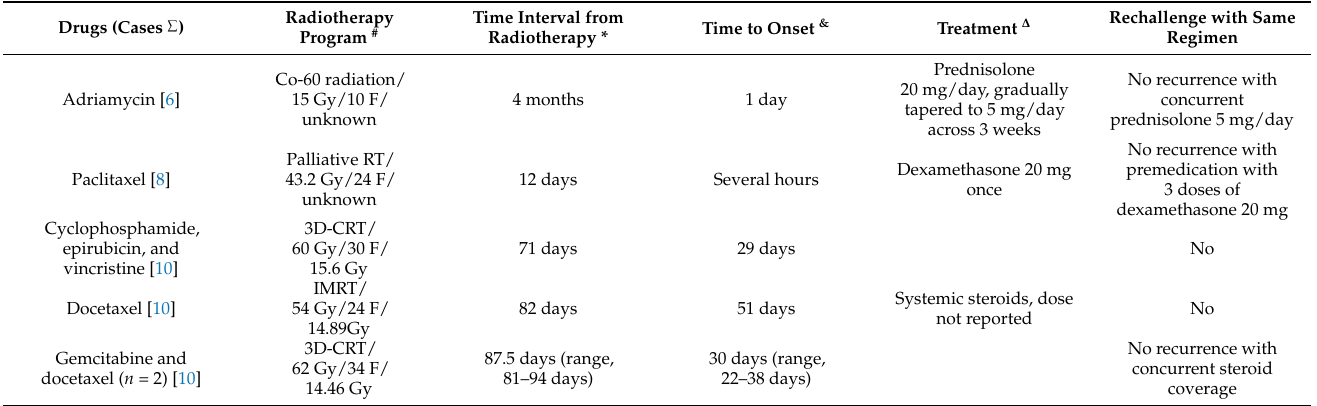
Table 1. Summary of published cases of RRP induced by